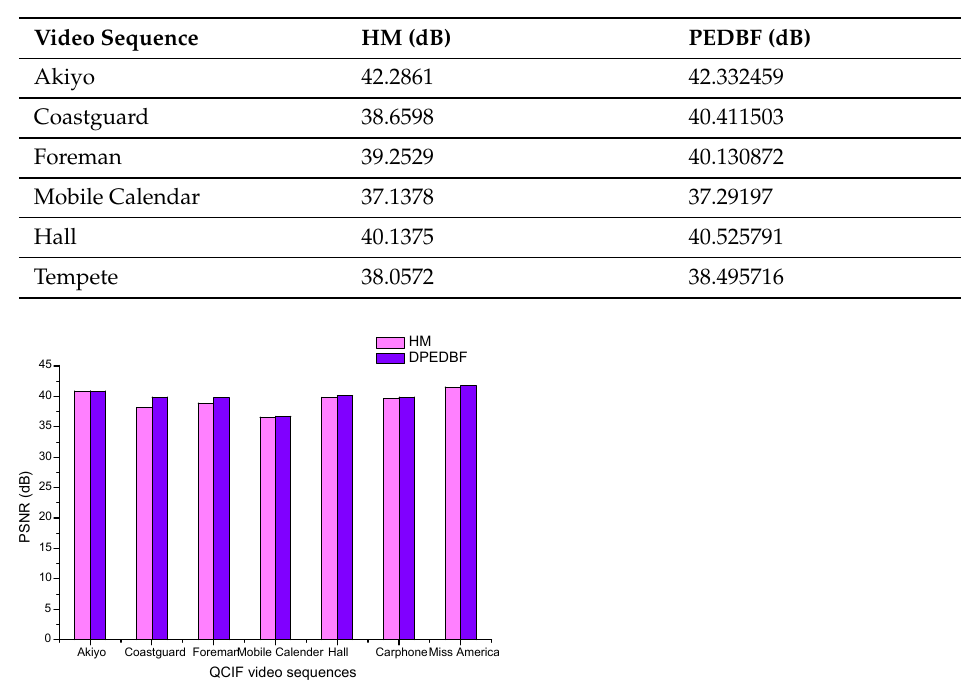
Table 10. PSNR of CIF video sequences with QP = 27.